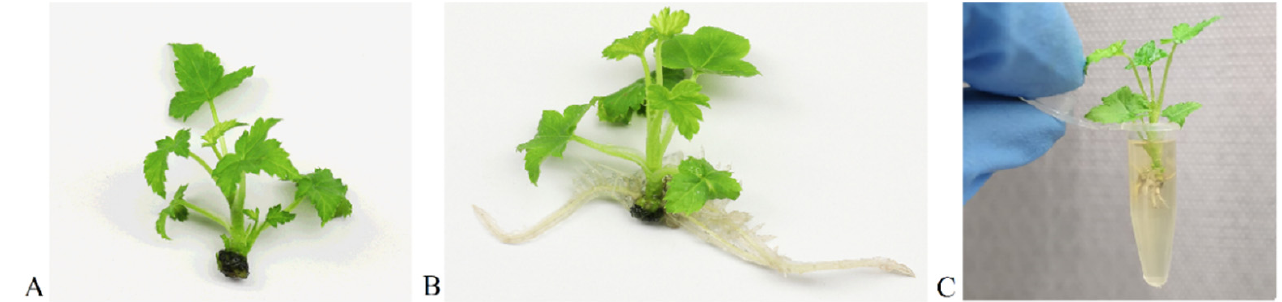
Figure 4. In vitro inoculation of R. nigrum microshoots: ( A ) microshoot before rooting; ( B ) microshoot with roots; ( C ) microshoot soaked in the tube with inoculum.